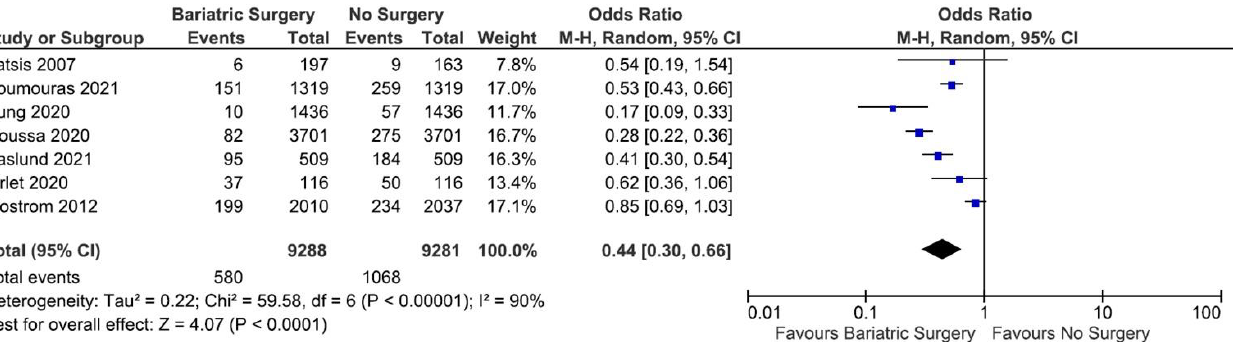
Figure 6. Forest plot of the MACE incidence comparing bariatric surgery with no surgery excluding studies with an une- qual sample size between the arms.